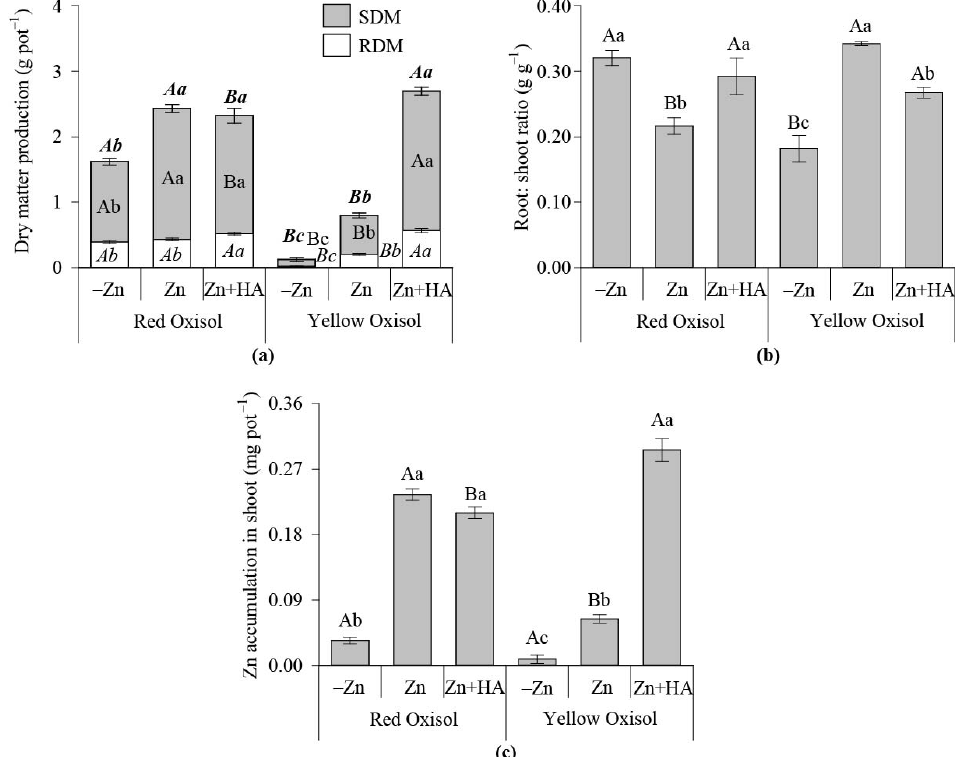
Figure 4. Effect of Zn fertilization and humic acid (HA) application on brachiaria growth traits and Zn nutrition of plants grown in contrasting Oxisols. Dry matter production ( a ); Root: shoot ratio ( b ); Zn accumulated in brachiaria shoot ( c ). SDM: shoot dry matter production; RDM: root dry matter production; full bar in the biomass graph represents the total dry matter production (TDM). Bars followed by the same capital letter do not differentiate the soil types according to the Zn fertilization strategies studied by the Tukey test ( p < 0.05). Bars followed by the same lowercase letter do not differentiate the Zn fertilization system adopted to each soil type according to the Tukey test ( p < 0.05). The combined use of bold-italic letters was used to compare TDM treatment means; the use of italics compared the values of RDM across the treatments. − Zn: no-Zn fertilization; Zn: Zn fertilization; Zn + HA: Zn fertilization combined with HA application.